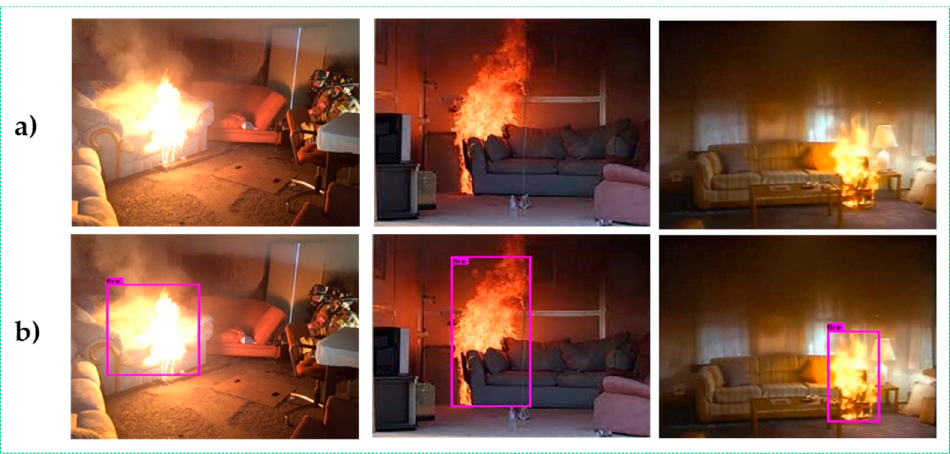
Figure 6. Results of the experiment that may be observed in nighttime fire scenarios include the ( a ) input image sequences and the ( b ) output image sequences with fire regions detected. Table 4. Full description of the smart glasses.